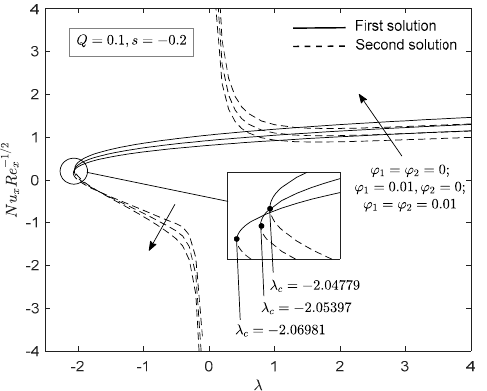
Figure 7. Nu x Re − 1/2 x for selected nanoparticles when s = − 0.2. − for selected nanoparticles when 0.2 s = − . Figure 7 . 1/2 Re x − for selected nanoparticles when 0.2 s = − . Figure 7 . 1/2 Re x